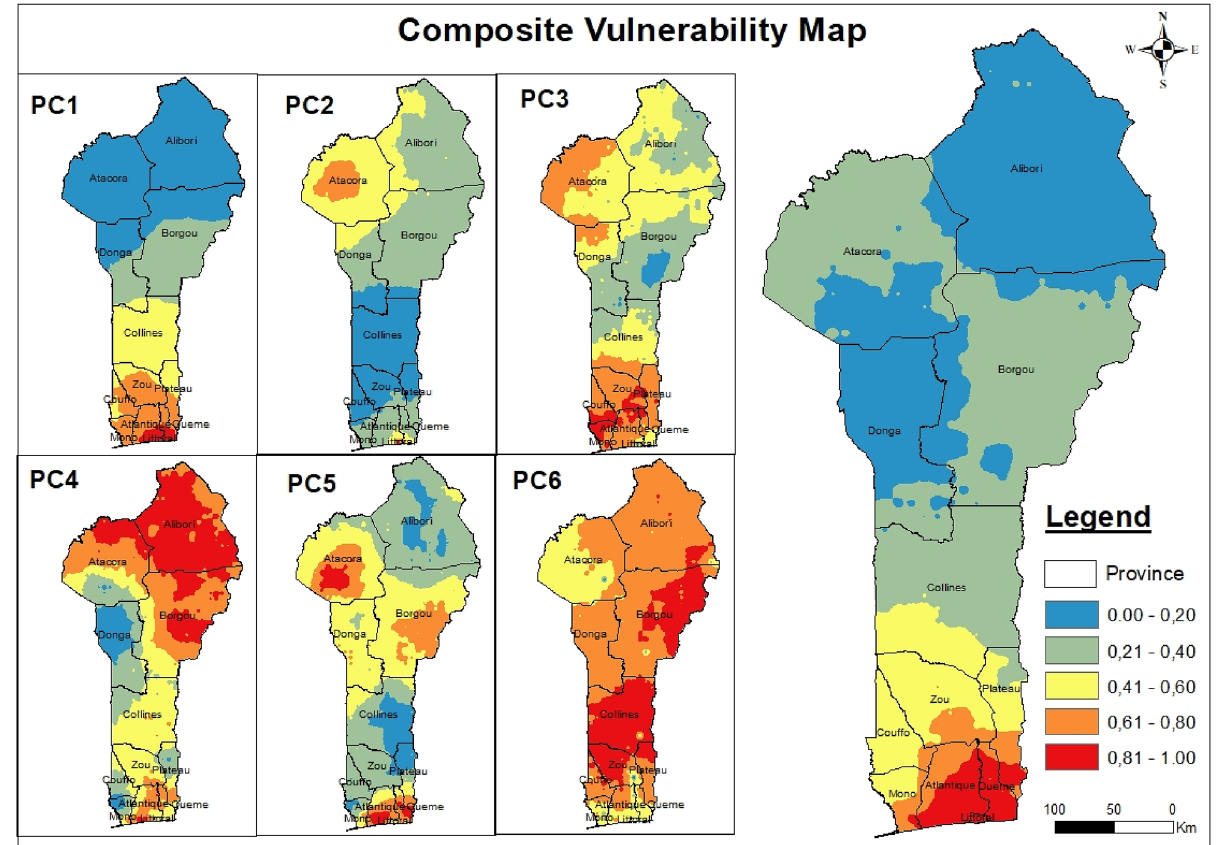
Figure 2. Composite vulnerability